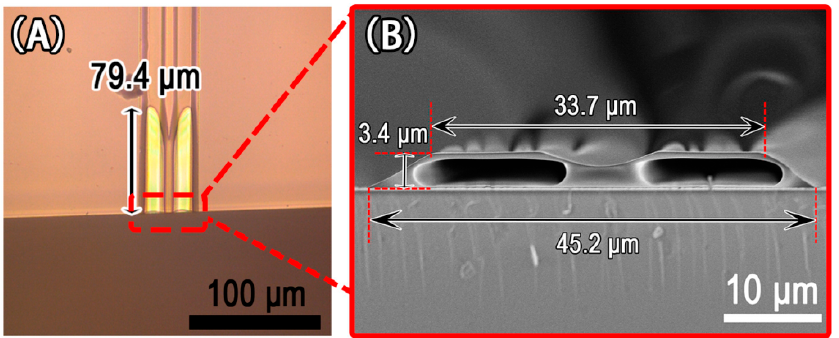
Figure 5. Schematic illustration of fabricating two parallel microchannels with ordinary PDMS mold ( A ) and PDMS guiding mold ( B ).